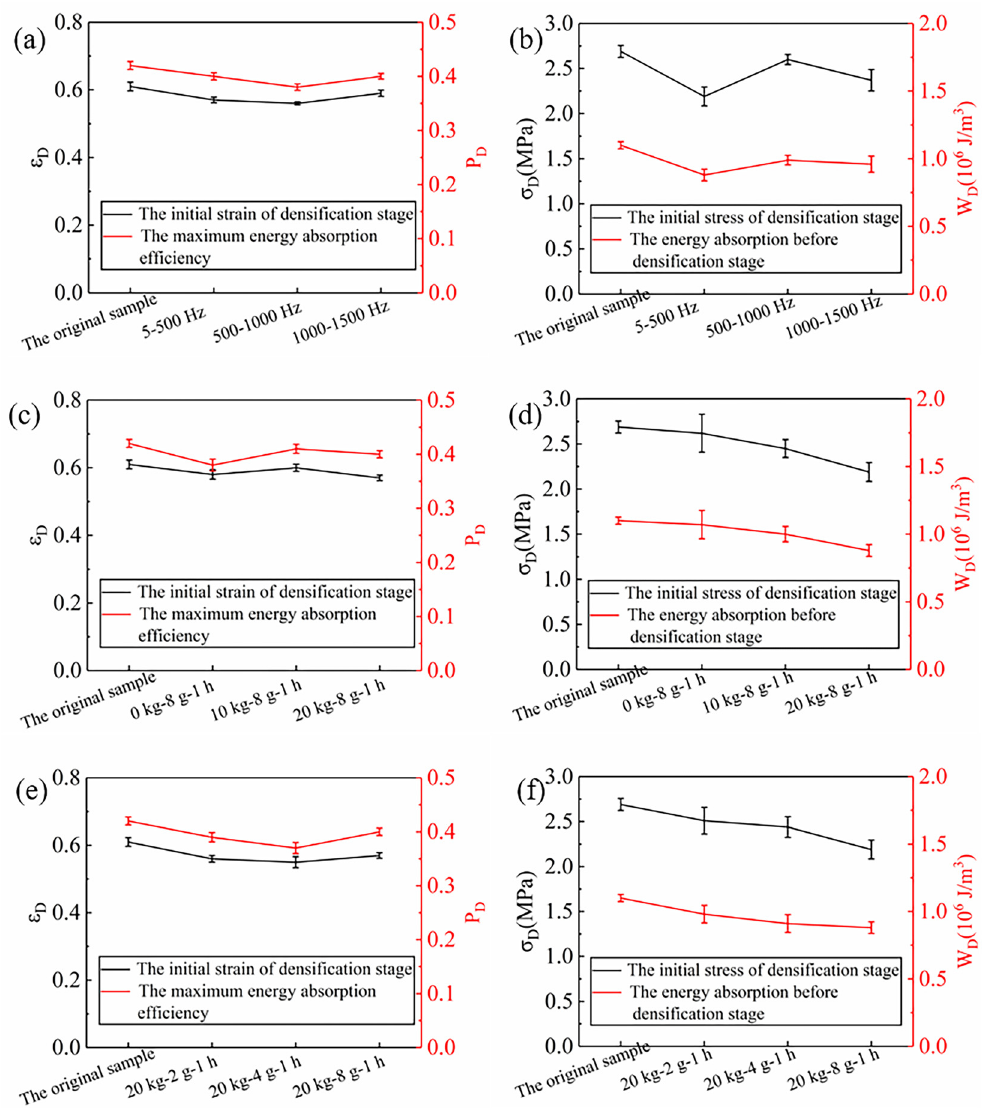
Figure 8. Compression energy absorption properties of the RPUF under different vibration conditions, ( a , b ) Different frequency ranges, ( c , d ) Different mass blocks, ( e , f ) Different accelerations.